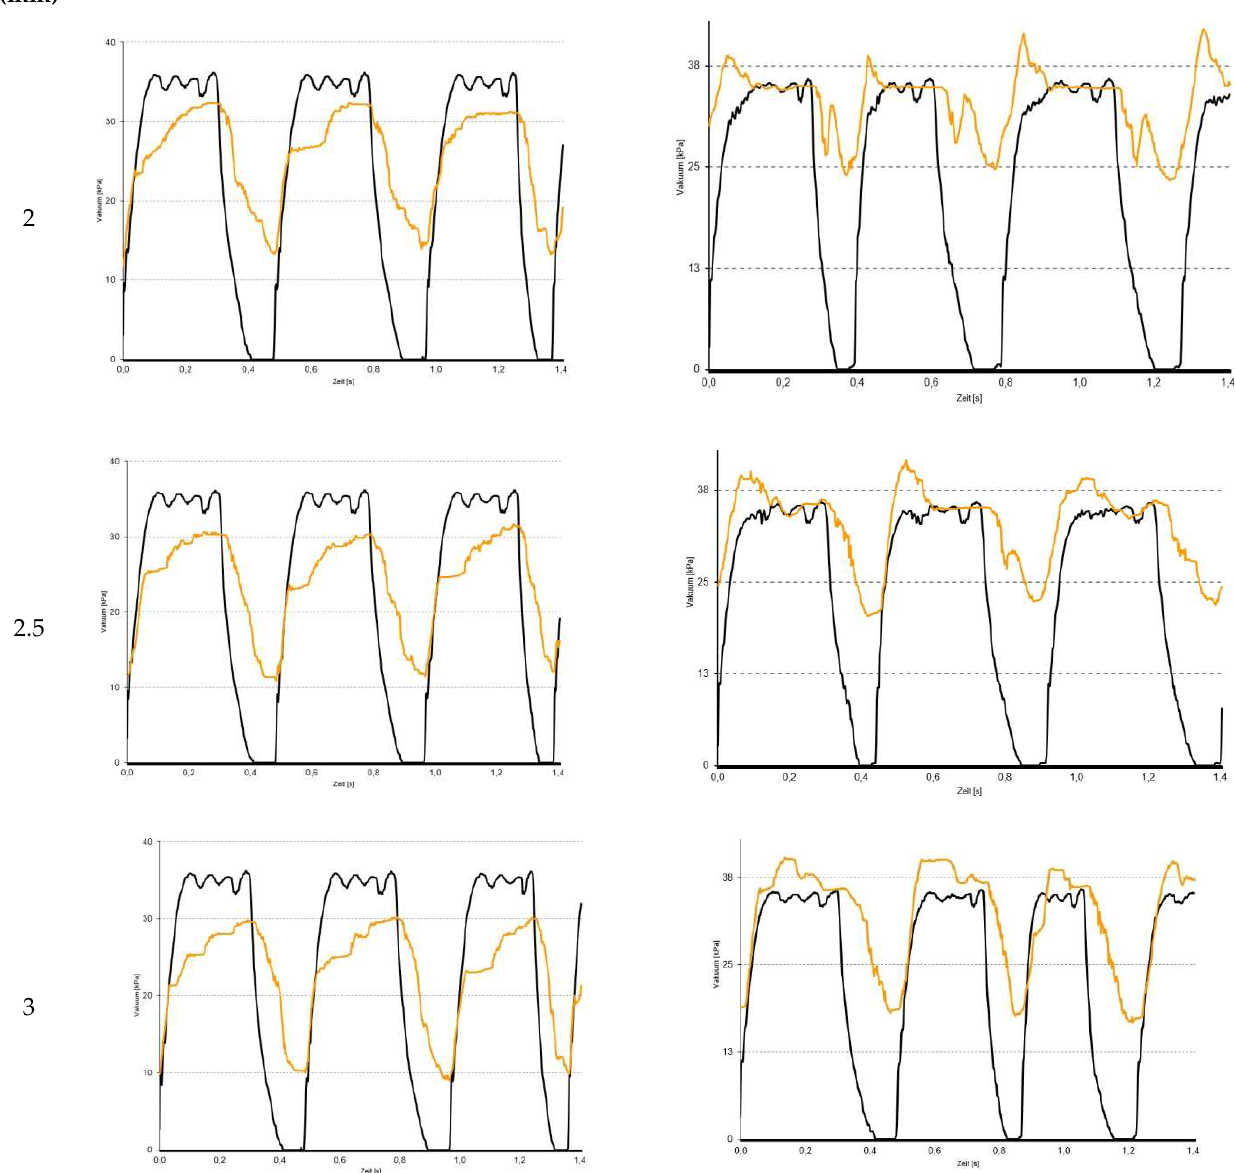
Figure 2. Cyclical vacuum fluctuations in the pulsation and inner chambers of the teat cup during the 1st WF in the sheep milking machine with the following settings: 36 vacuum level (kPa), 120 pulsation rate (cycles/min) and 60:40 pulsation ratio.